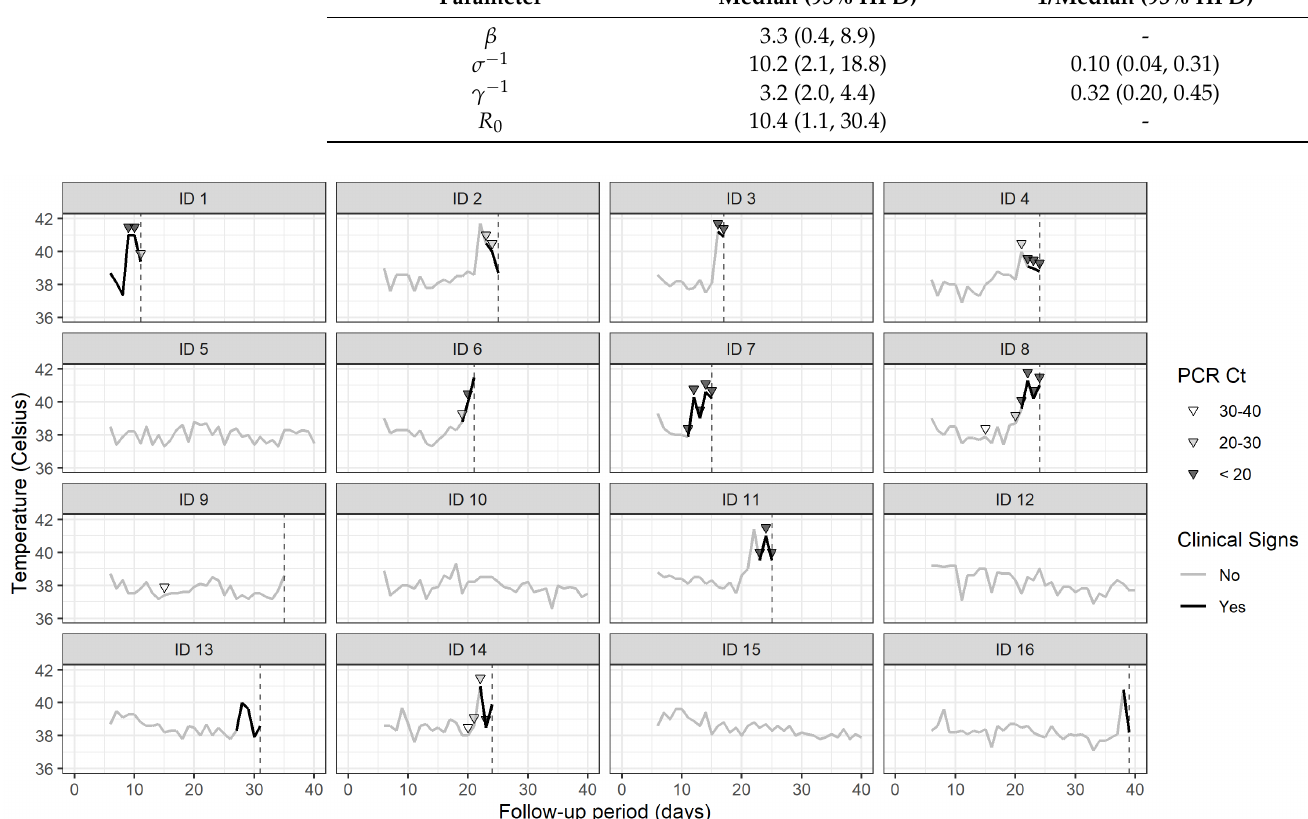
Figure 3. Line plots showing rectal temperature for individual pigs as a function of the number of days 15 March 2019. On each plot, the days on which pigs were showing clinical signs of ASF are shown in black. The days on which blood samples were taken from individual pigs are marked on each plot as inverted triangles, with shading indicating the PCR Ct value.